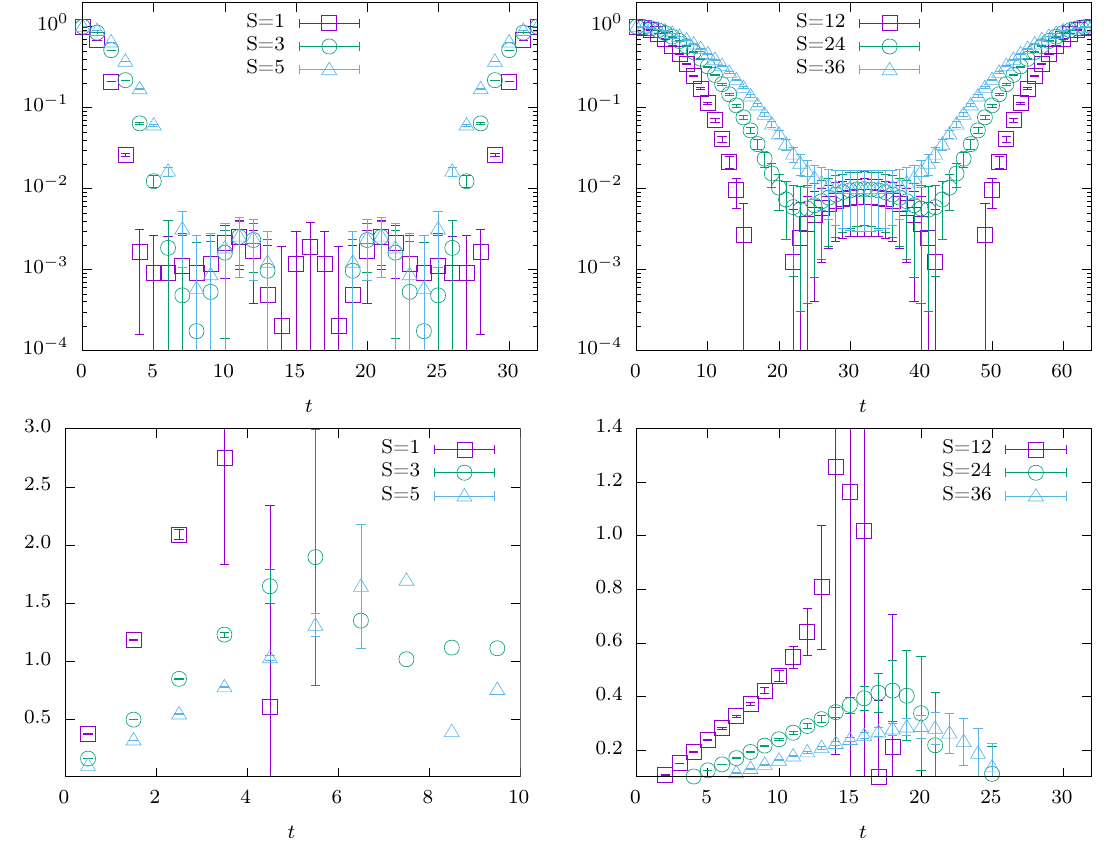
Figure 14. Comparison between the glueball correlation function C ( t ) as function of the temporal extend t for the two-dimensional Yang-Mills theory (left) and the two-dimensional Super Yang-Mills theory (right) for di(cid:11)erent smearing levels S . In the bottom row we plot the e(cid:11)ective